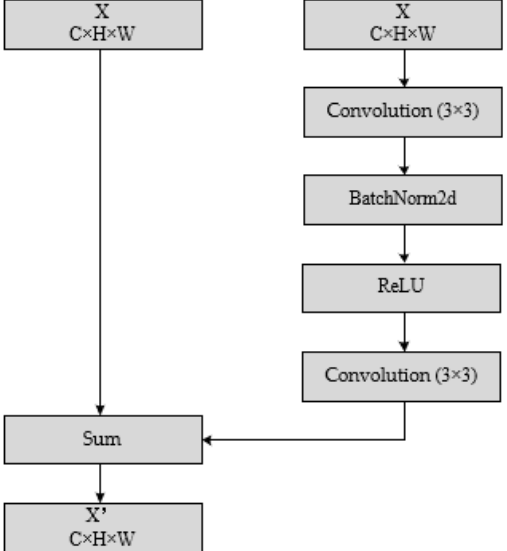
Figure 3. Feature extraction module structure.